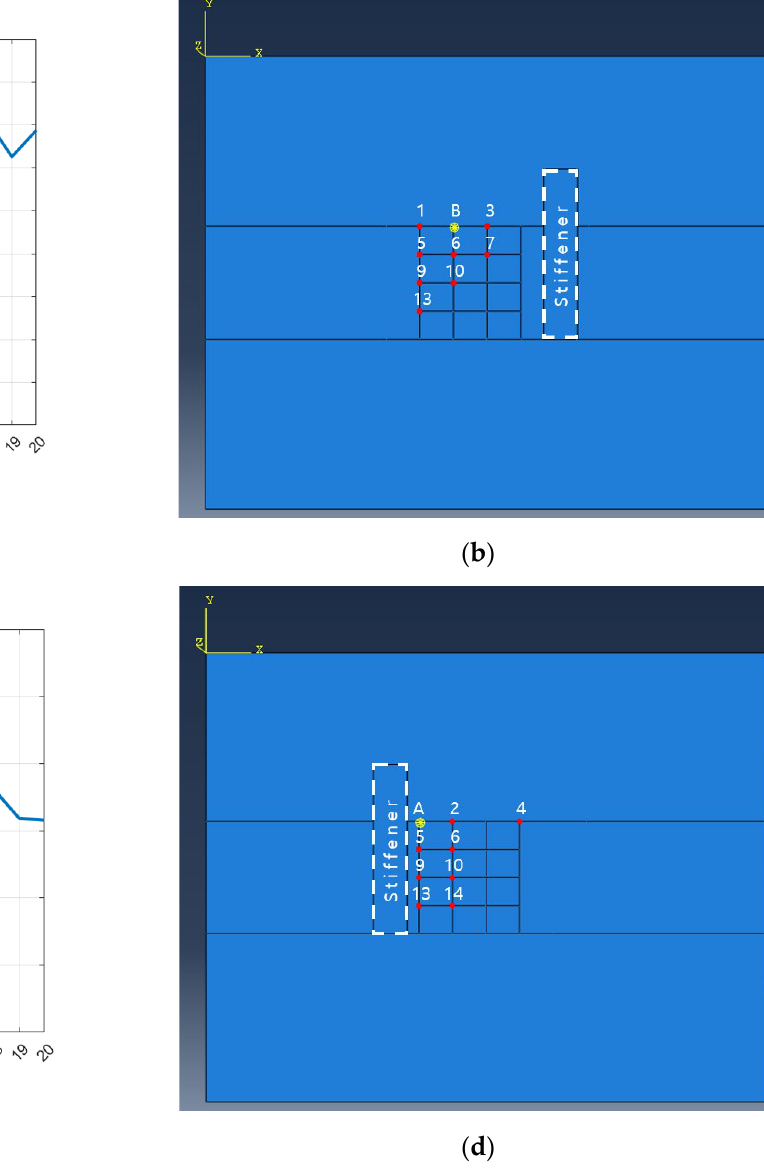
Figure 14. ( a ) Averaged magnitude of the reflective waves from defects measured by each sensor where stiffener is attached on the right side of panel; ( b ) optimal transducer array configuration where stiffener is attached on the right side of panel; ( c ) averaged magnitude of the reflective waves from defects measured by each sensor where stiffener is attached on the left side of panel; ( d ). optimal transducer array configuration where stiffener is attached on the left side of